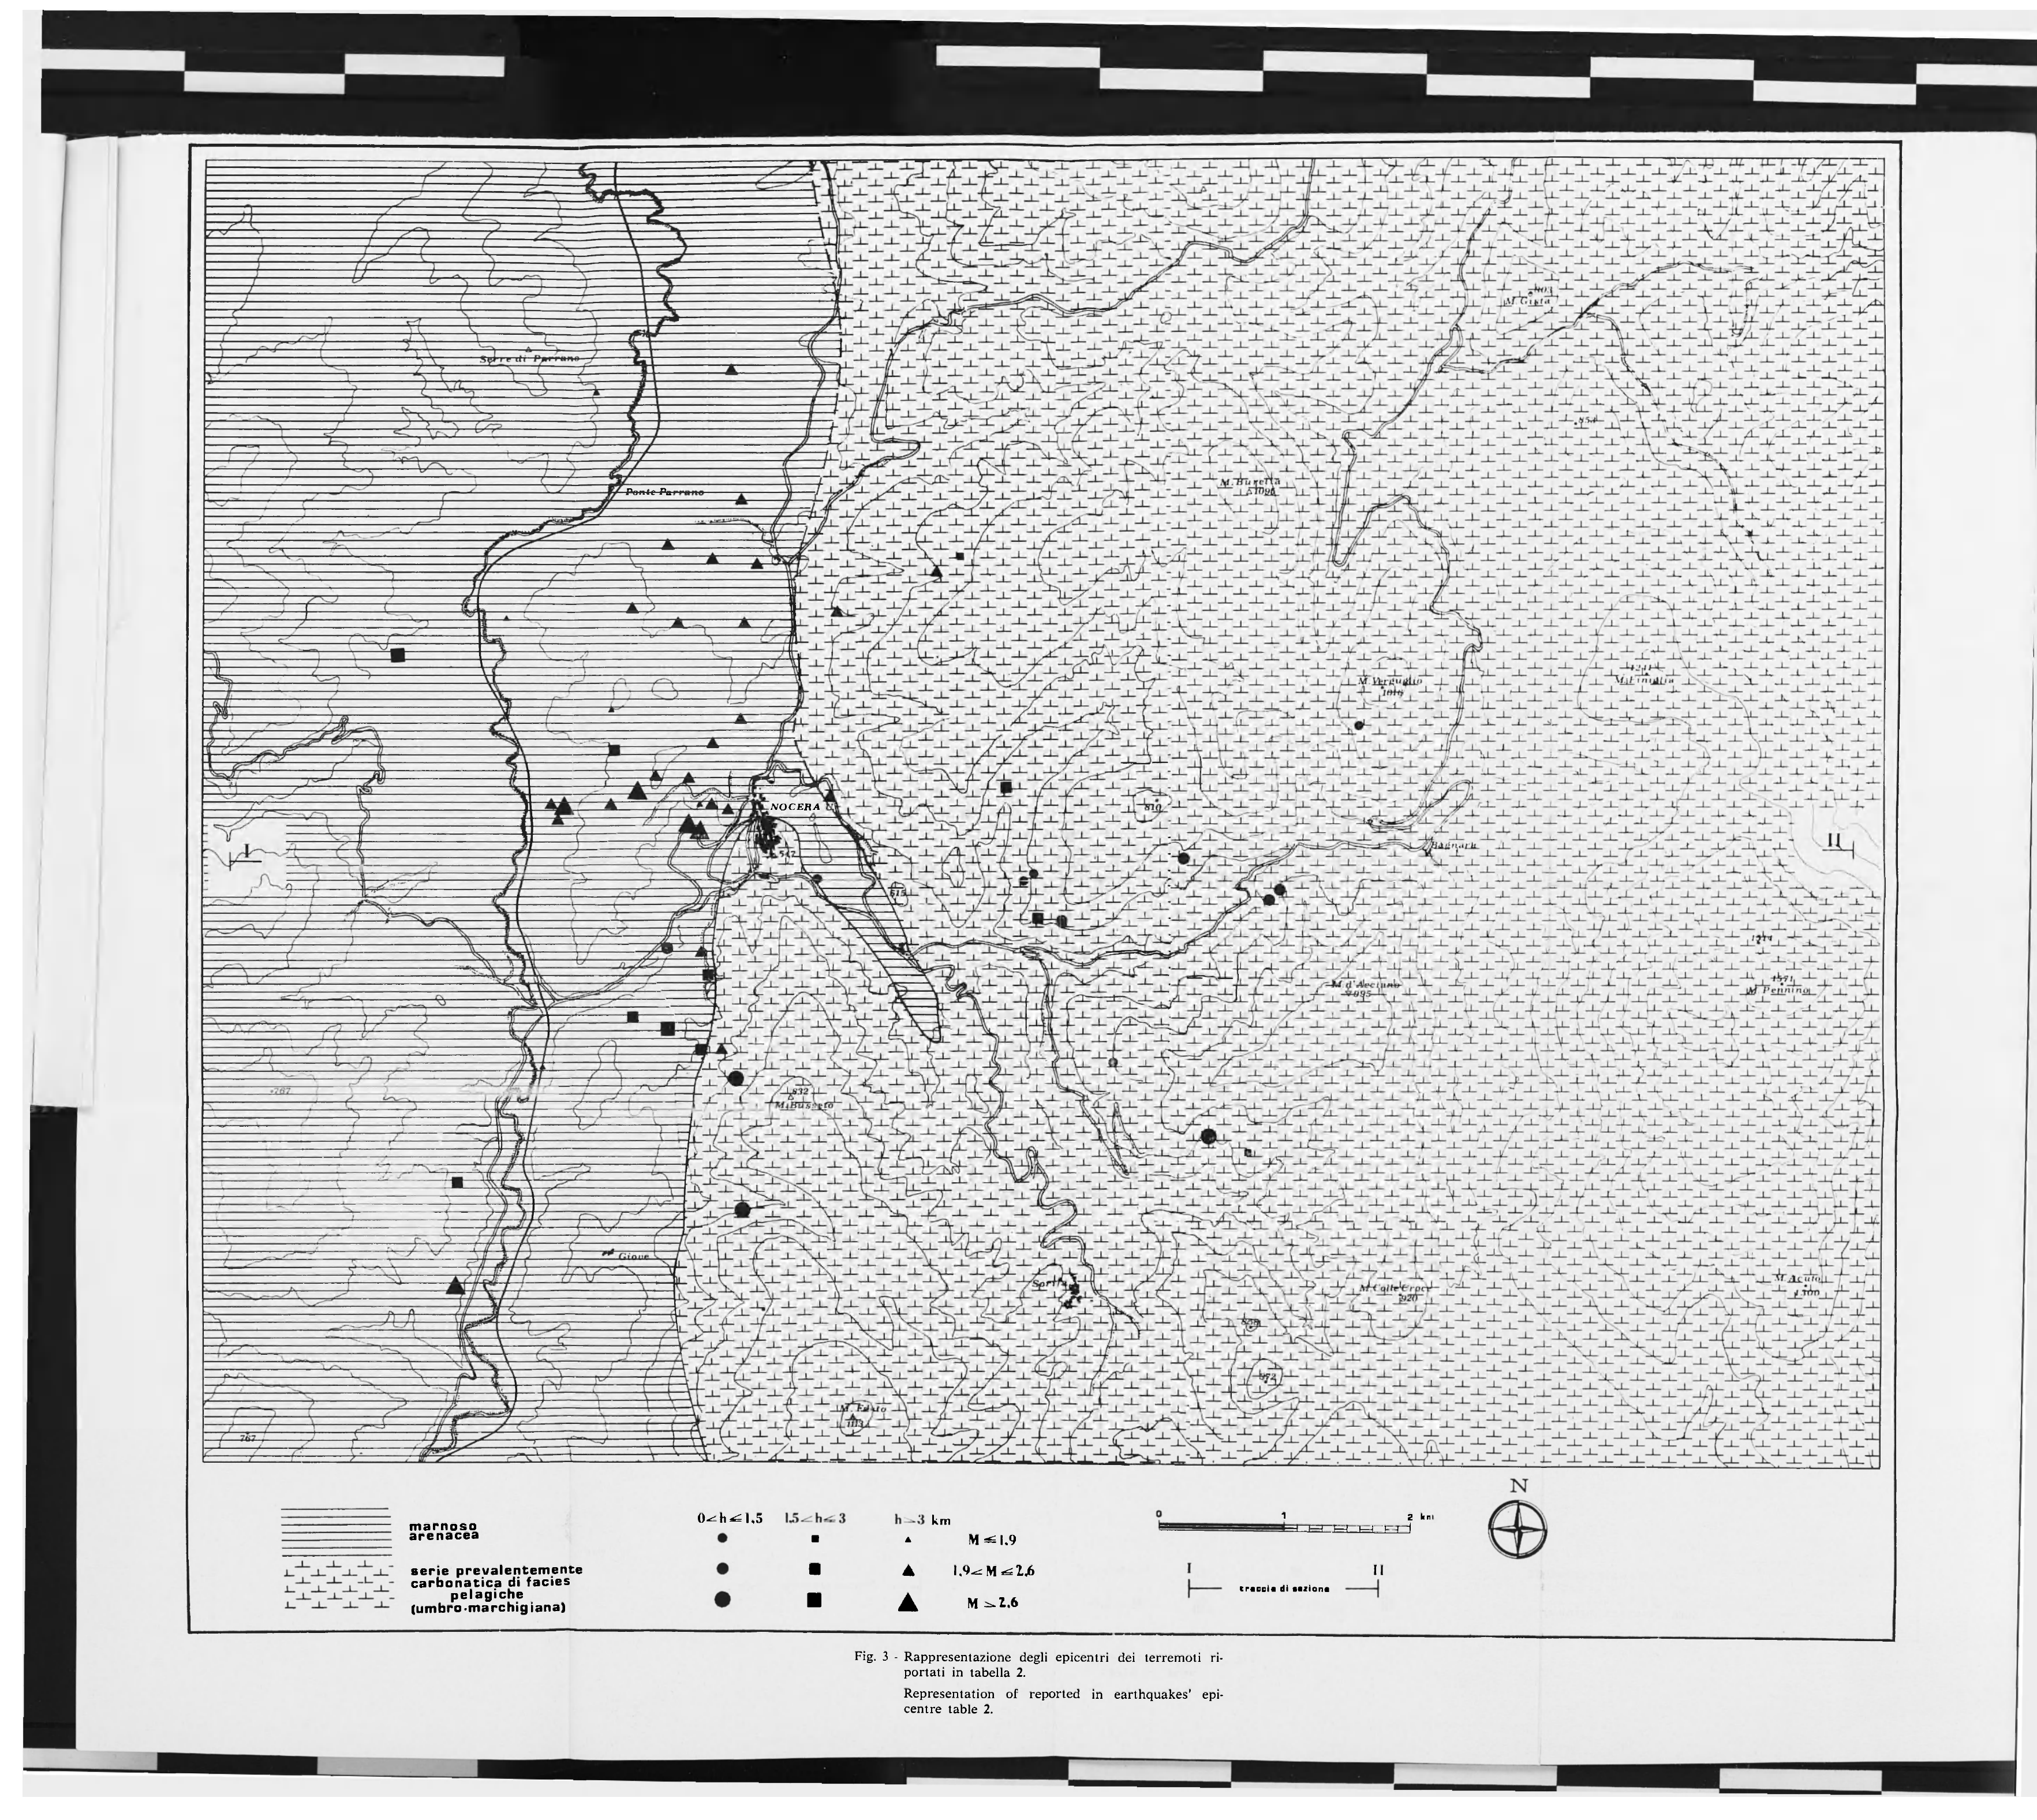
Fig. 3 - Rappresentazione degli epicentri dei terremoti ri- portati in tabella